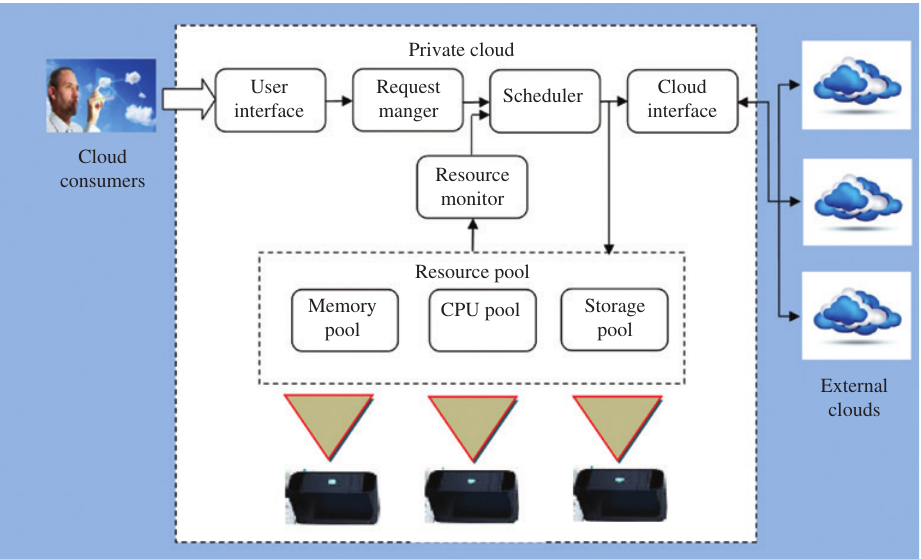
Figure 1: Component View of a Hybrid Cloud